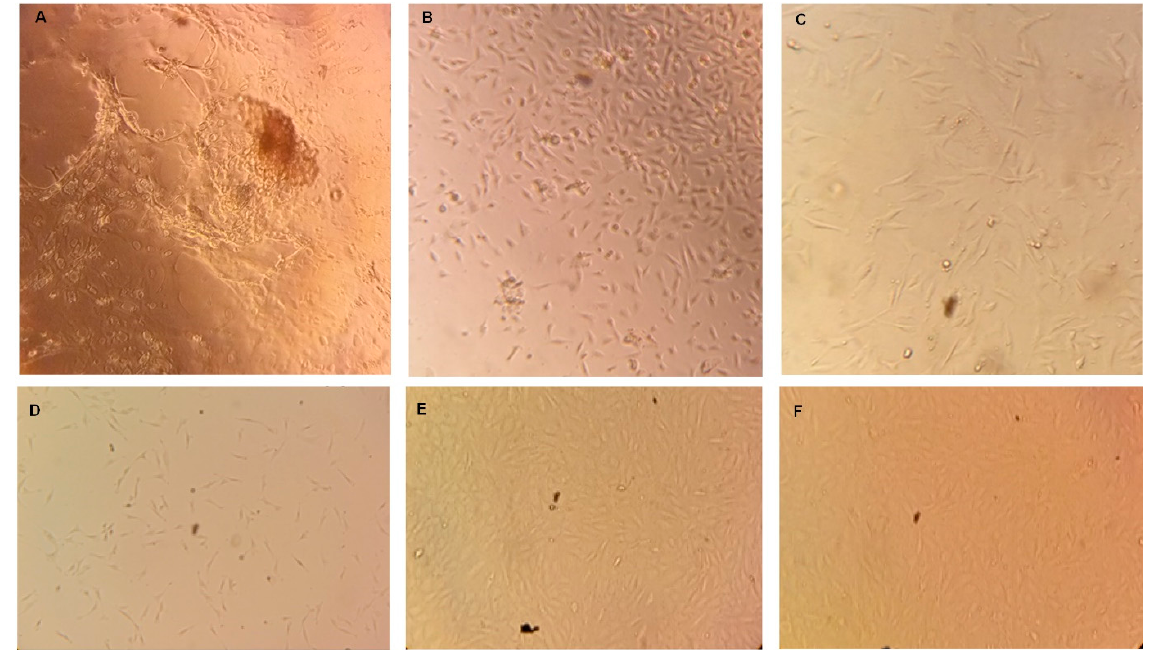
Figure 2. Isolation, culturing and reviving of bovine fungiform taste bud cells. ( A ) Taste bud cells in 24-well plates after 6 days of seeding. ( B ) Cells in 24-well plates after 9 days of seeding. ( C ) Cells in 25-mL flask after 48 hours of seeding. ( D ) Revived BTBCs following cryopreservation Passage-3 cells; ( E ) Passage-4 cells and ( F ) Passage-5 cells.